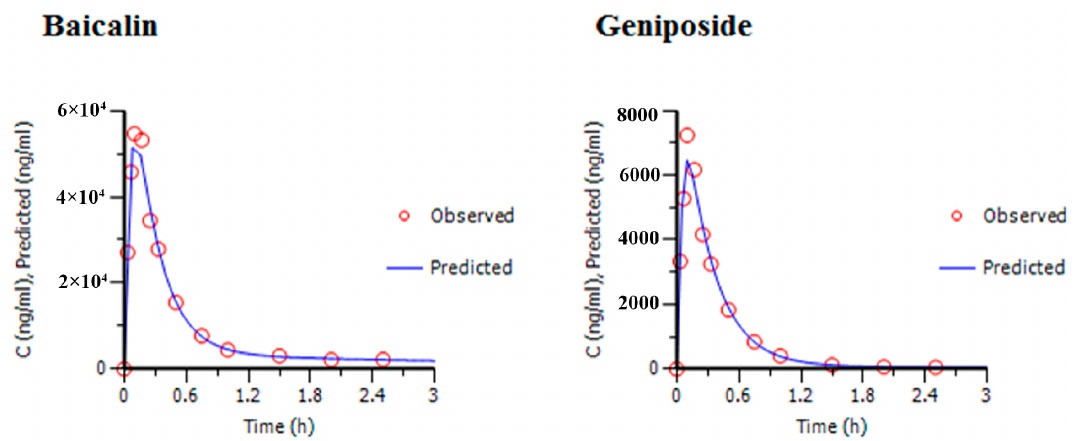
temperature change) and the plasma concentrations of baicalin and geniposide.